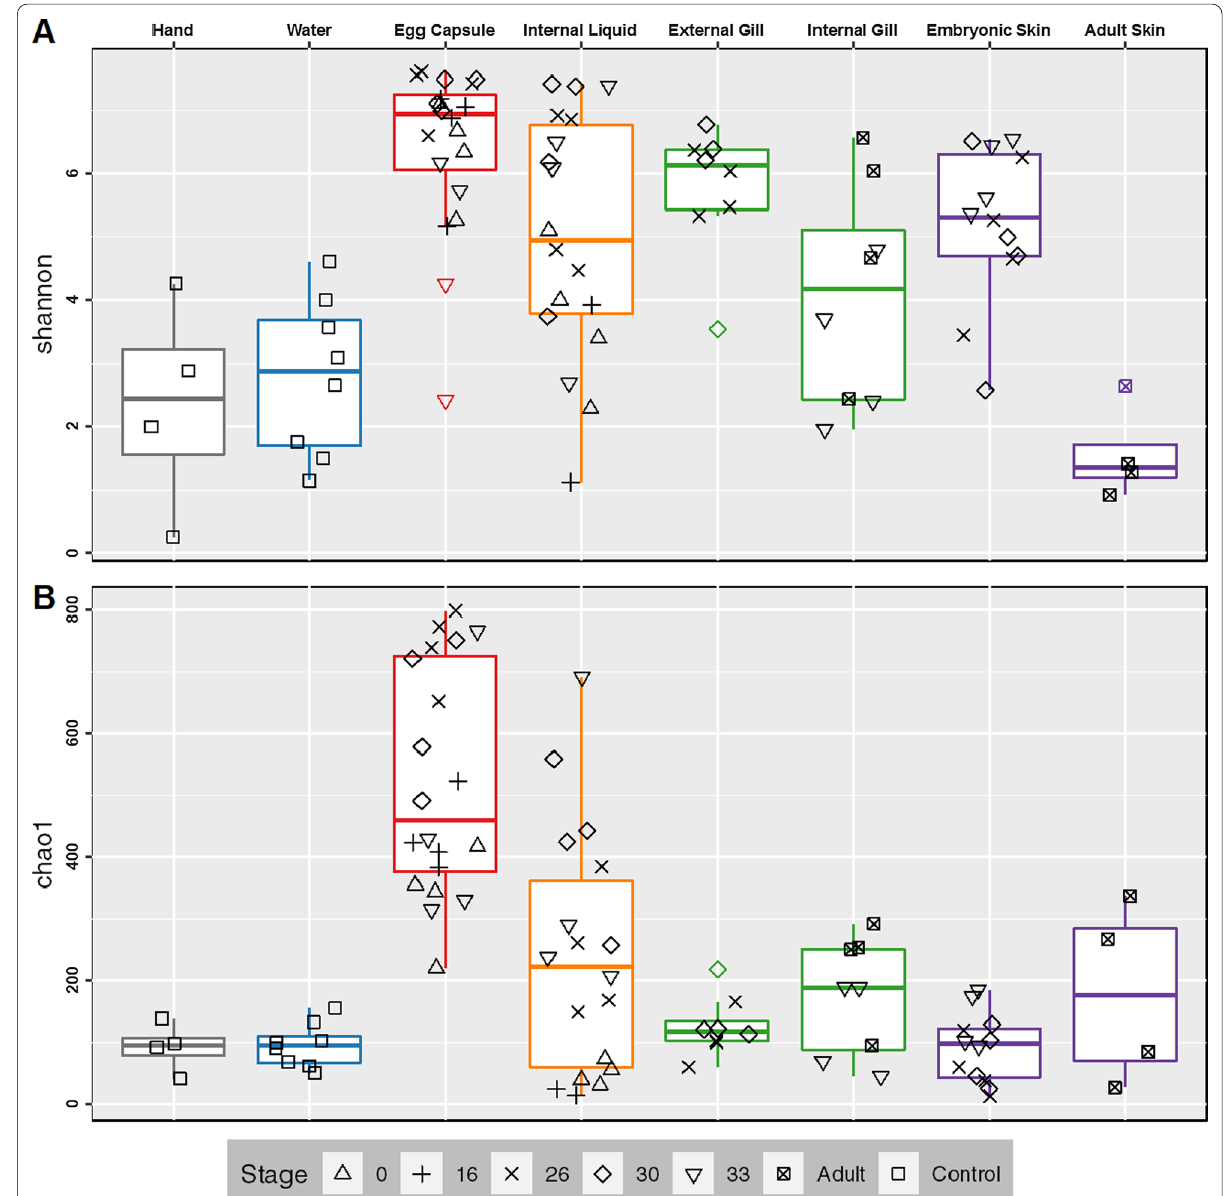
Fig. 3 Alpha diversity of embryonic and adult skate bacterial communities. Boxplots of Shannon ( A ) and Chao1 ( B ) alpha diversity metrics for each sample site. Datapoints shown in black. Colored points are statistical outliers. Stage is indicated by shape. Grey: experimenters’ hands, blue: water, red: egg capsule, orange: internal liquid, green: gill, and purple: